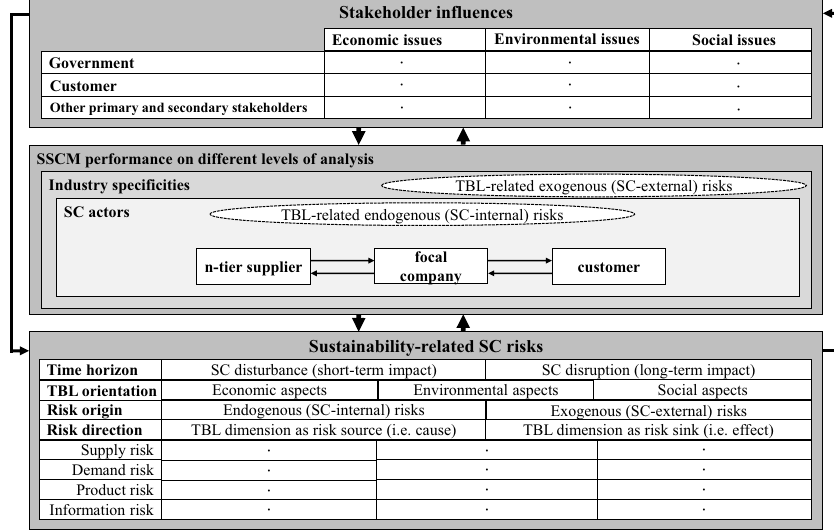
Fig. 7 Conceptual framework of stakeholder influences and risks in